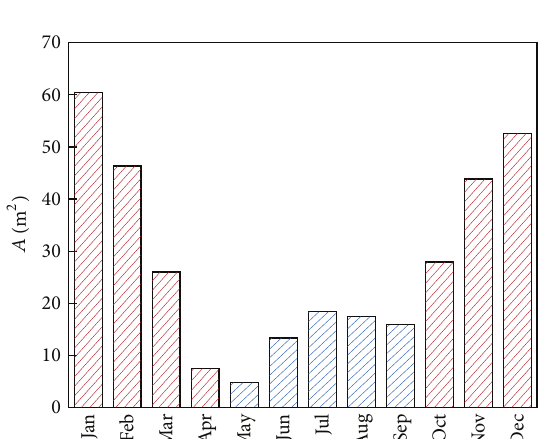
Figure 17: Monthly PV panel minimum required area and system exergy destruction